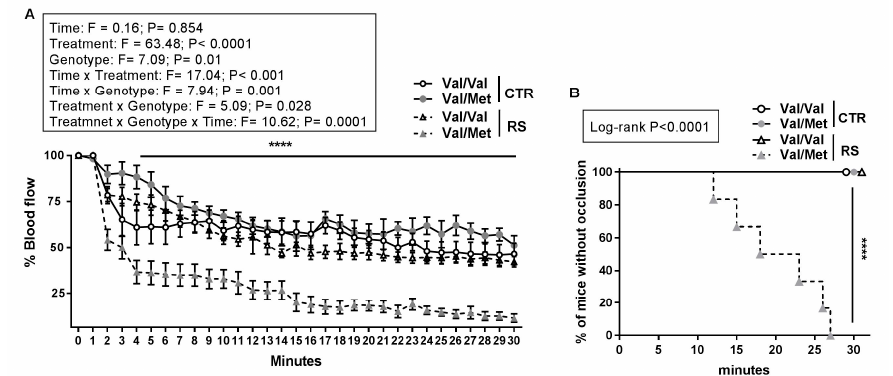
Figure 2. Effect of restraint stress on arterial thrombosis in BDNF Val/Val and BDNF Val/Met mice. Arterial thrombosis was induced by topical application of FeCl 3 to carotid artery in mice. ( A ) Blood flow in the carotid arteries of stressed (RS) and not stressed (CTR) BDNF Val/Val and BDNF Val/Met mice groups. n = 6 mice/group. Data shown are mean ± SEM. Three-way ANOVA with repeated measures followed by Bonferroni post hoc analysis, p values were obtained by using log-transformed variables. ( B ) Kaplan-Meier curve representing percentage of mice without occlusion through time. n = 6 mice/group. p values were obtained by analysing Kaplan-Meier curves by Log-Rank tests. **** p < 0.001.